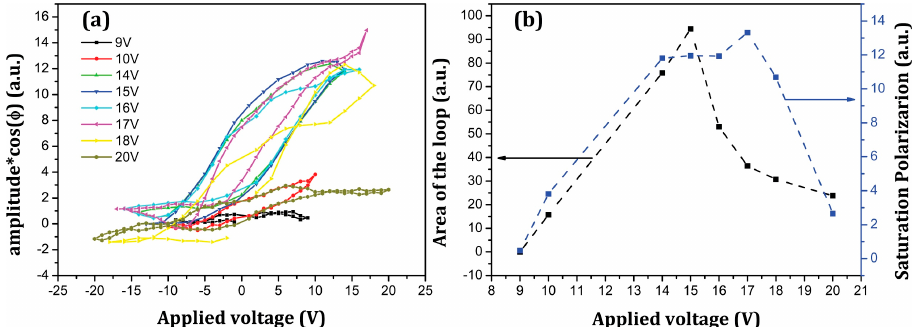
Figure 4. PFM hysteresis loops measured under different voltages ( a ) and maximum voltage dependence of the area of the loop and maximum piezoresponse ( b ).